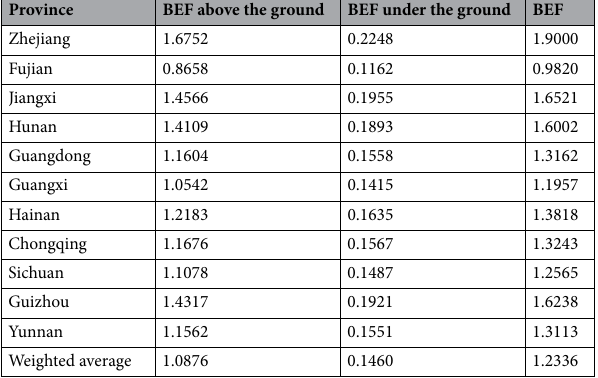
Table 12. BEF of eucalyptus by province.